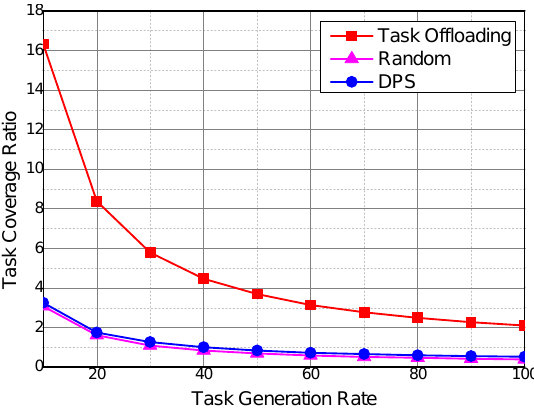
Figure 13. Impact of task generation rate on task coverage